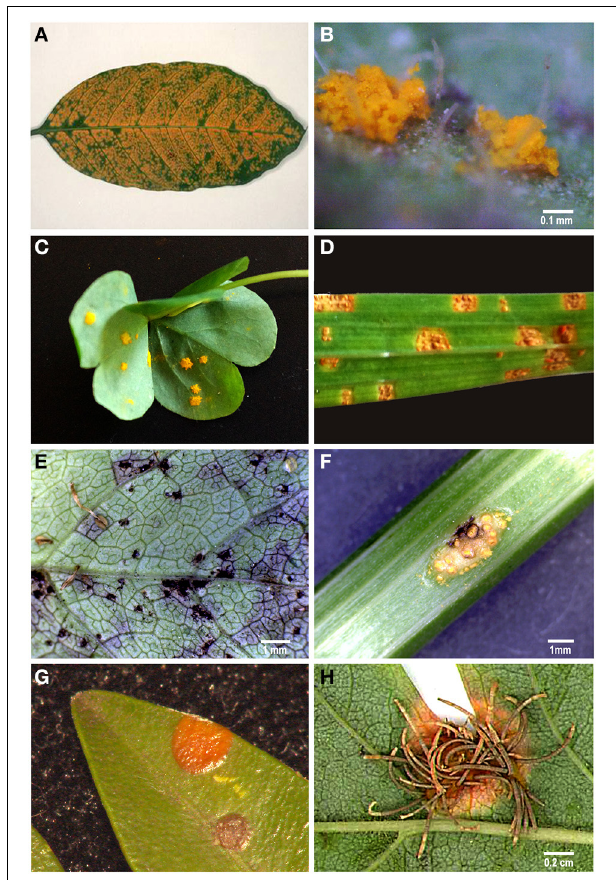
FIGURE 1 | Examples of rust sporulation. (A) Hemileia vastatrix uredinia on a Coffea arabica leaf; (B) Phragmidium mexicanum uredinia on a Duchesnea indica leaf; (C) Puccinia oxalidis uredinia on a Oxalis articulata leaf; (D) Uromyces transversalis uredinia on a Gladiolus sp. leaf; (E) Puccinia smyrnii telia on a Smyrnium olusatrum leaf; (F) Puccinia smyrnii aecia on a Smyrnium olusatrum stem; (G) Puccinia buxi telia on a Buxus sempervirens leaf; (H) Gymnosporangium confusum aecia on a Crataegus monogyna